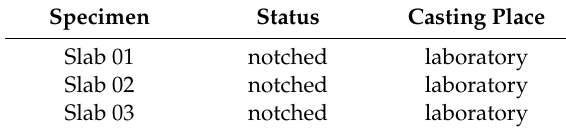
Figure 10. Experimental punching test campaign. Table 4. Specimens characteristics summarization.